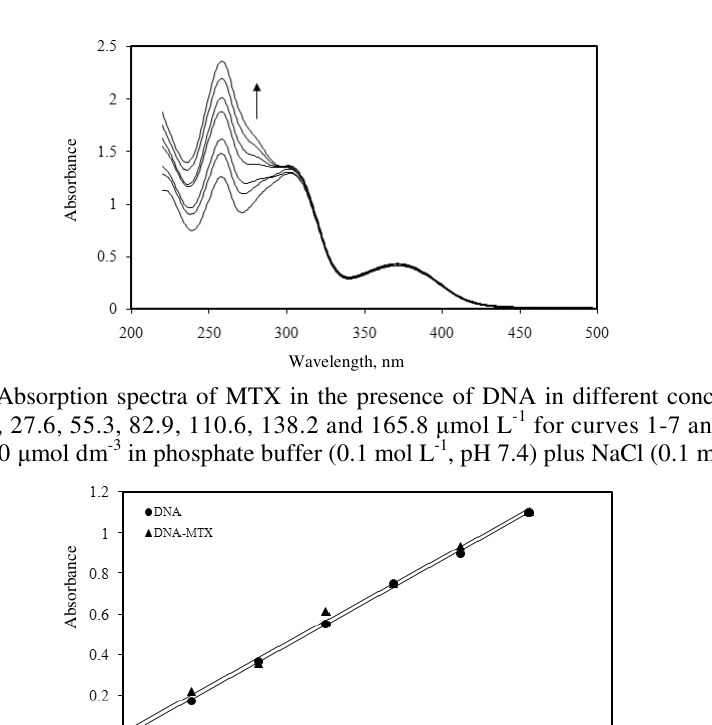
= 50.0 µ mol L -1 MTX